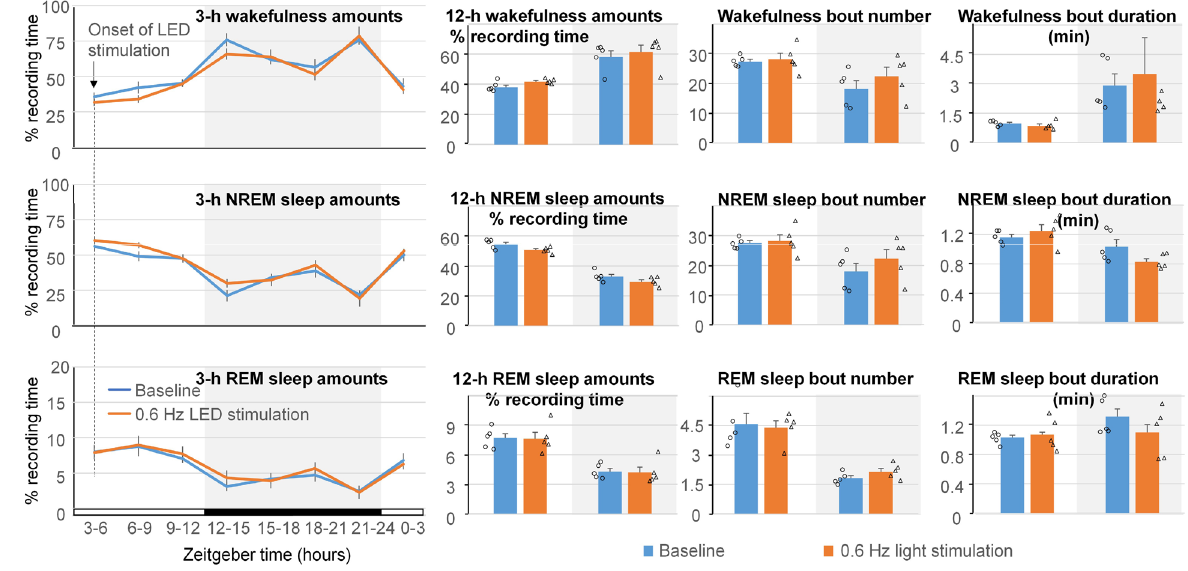
Figure 7. Effect of 24-h local stimulation of ChrimsonR containing neurons in the cerebral cortex with 400- ms 629-nm light pulses at 0.6 Hz on sleep pattern. No significant differences in the amounts of wakefulness, NREM sleep and REM sleep calculated in 3-h intervals between the baseline and stimulation day were found. Number and duration of sleep bouts also did not change significantly. However, an increase in the amounts of NREM sleep and reduction in the amounts of wakefulness were observed during the 12-h light on period. White background indicates light periods, and grey background indicates dark periods. * p < 0.05.